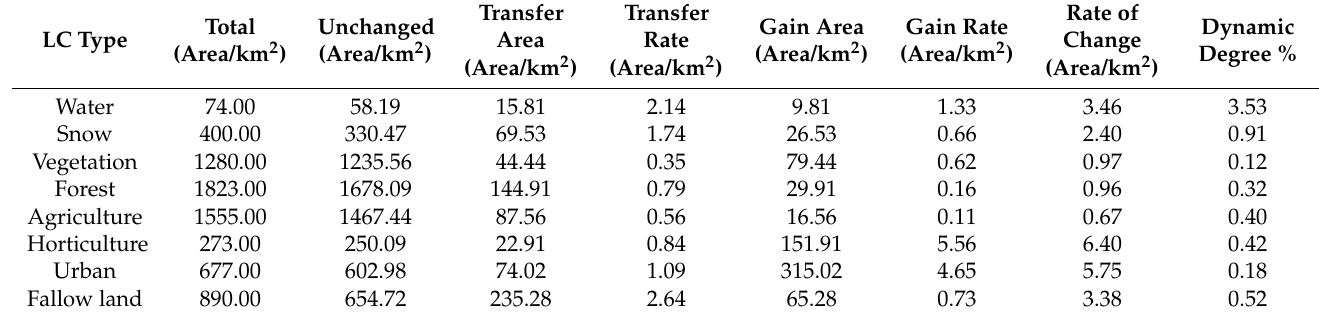
Table 5. The change rate of LC during 2000–2010.